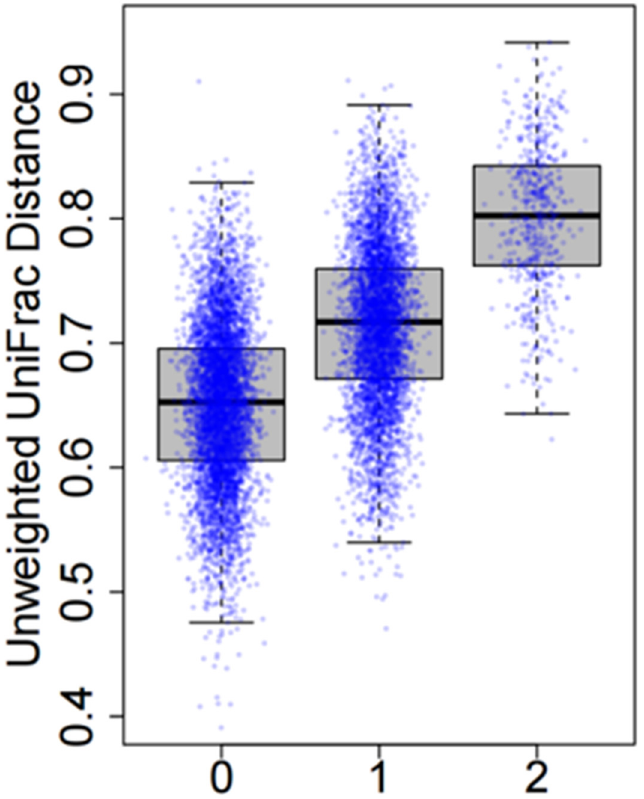
Figure 1. Microbiome distances are positively correlated with genetic distances at an associated SNP.